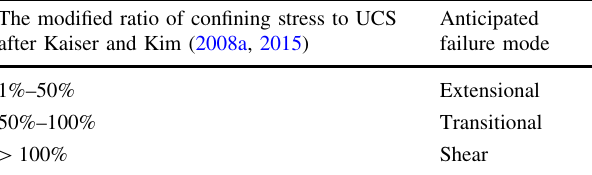
Table 1 Summary of the average mechanical properties The modified ratio of confining stress to UCS after Kaiser and Kim (2008a, 2015)